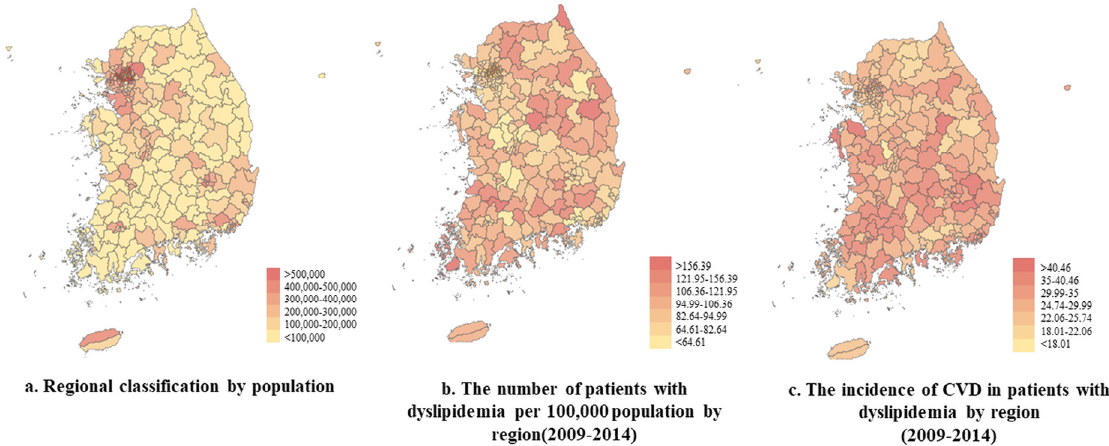
Figure 1. Regional classification by population, and the distributions of dyslipidemia and CVD by region (2009–2014). Figure 2 shows the distribution of abnormal serum cholesterol levels by region. In Korea, dyslipidemia patients showed a higher proportion (31.3%) of abnormalities in TC levels, and a lower proportion (12.5%) of abnormalities for low HDL-C levels. In regions of low population density, the proportion of abnormal TG levels was highest, but the proportion of high LDL-C levels was lowest. In regions with populations of more than 200,000, high TC had a similar distribution, and the proportion of low HDL-C was lower in regions with populations over